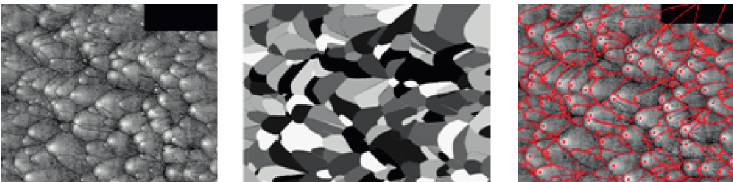
Fig. 2. Left side : Optical profilometer images taken from the fracture surfaces at velocities of 350 ms − 1 . Center : final image reconstruction of surface markings. Right : Superposition of the optical profiometer images vs. the reconstructions (red